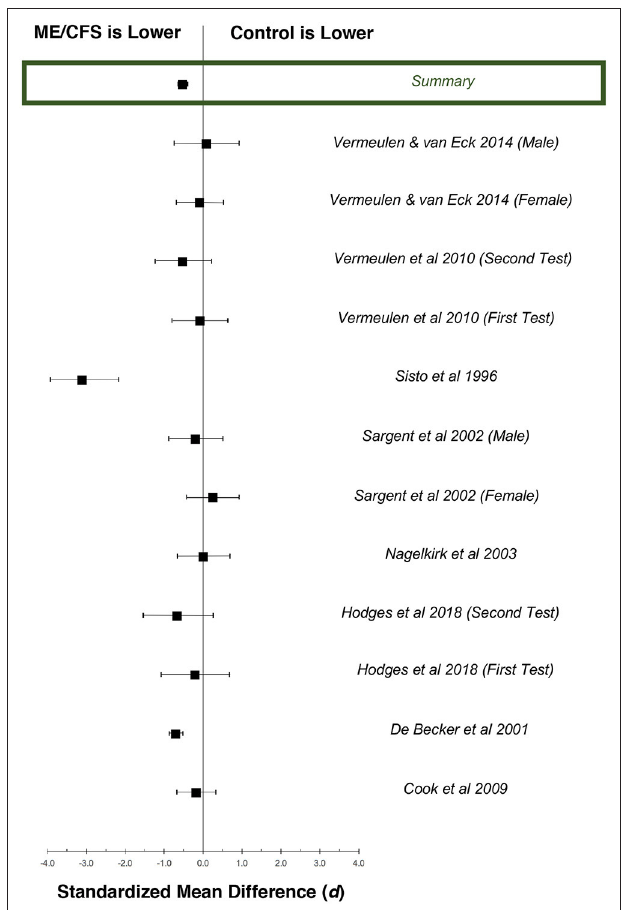
FIGURE 3 | Standardized mean differences ( d ) for exercise heart rate at ventilatory anaerobic threshold (VAT), comparing patients with ME/CFS ( n = 778) and matched control subjects ( n = 378). Boxes represent point estimates, and whiskers are 95% confidence intervals. Patients with ME/CFS had lower heart rates at VAT than matched control subjects (moderate effect